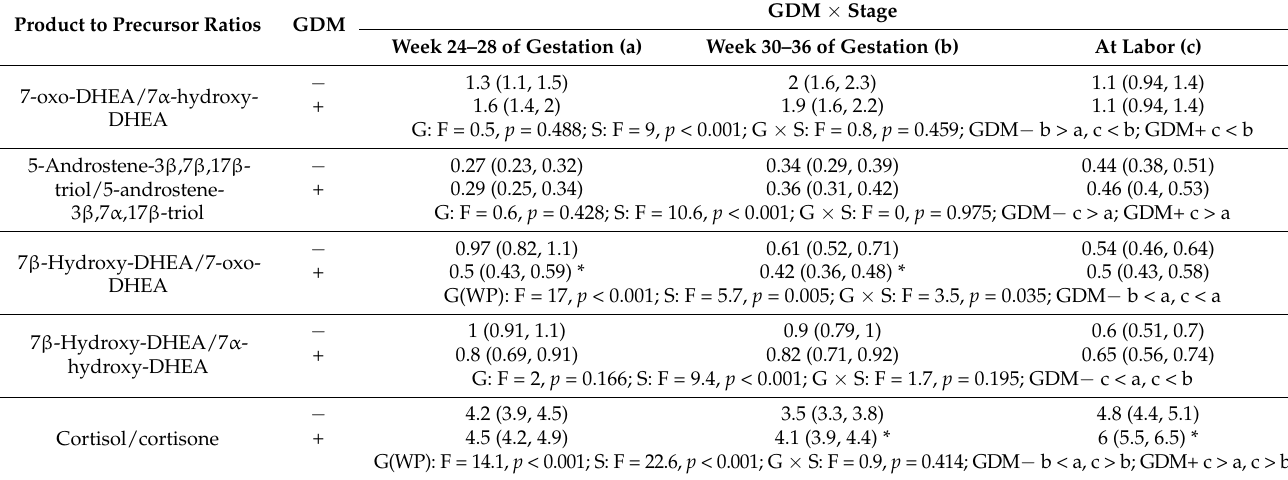
Table 9. Profiles of product to precursor ratios that may reflect HSD11B1 activity in the GDM − and GDM+ groups from week 24 of gestation to